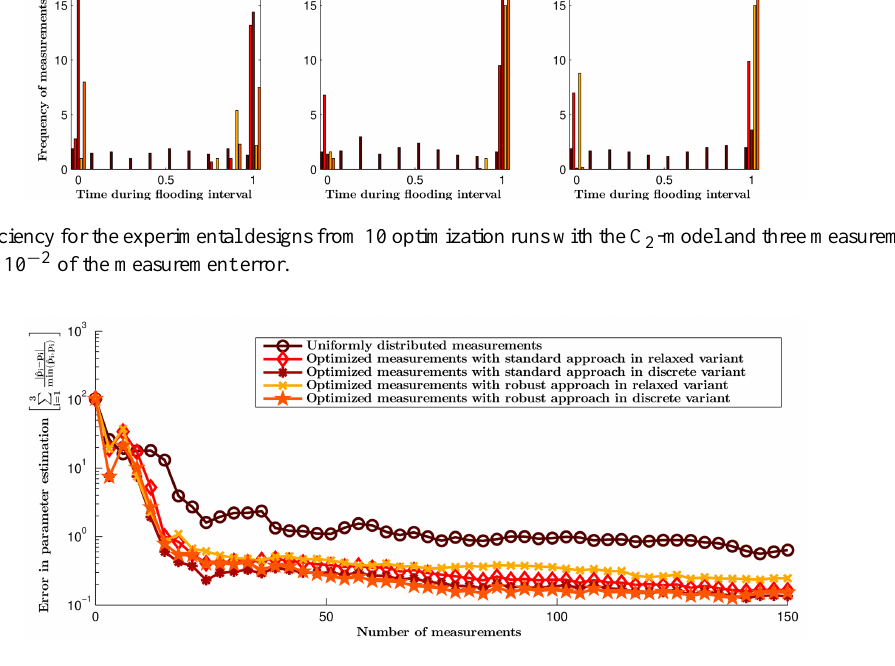
Figure 4. Averaged efficiency for the experimental designs from 10 optimization runs with the C 3 -model and three measurement per iteration with standard deviation 10 − 2 of the measurement